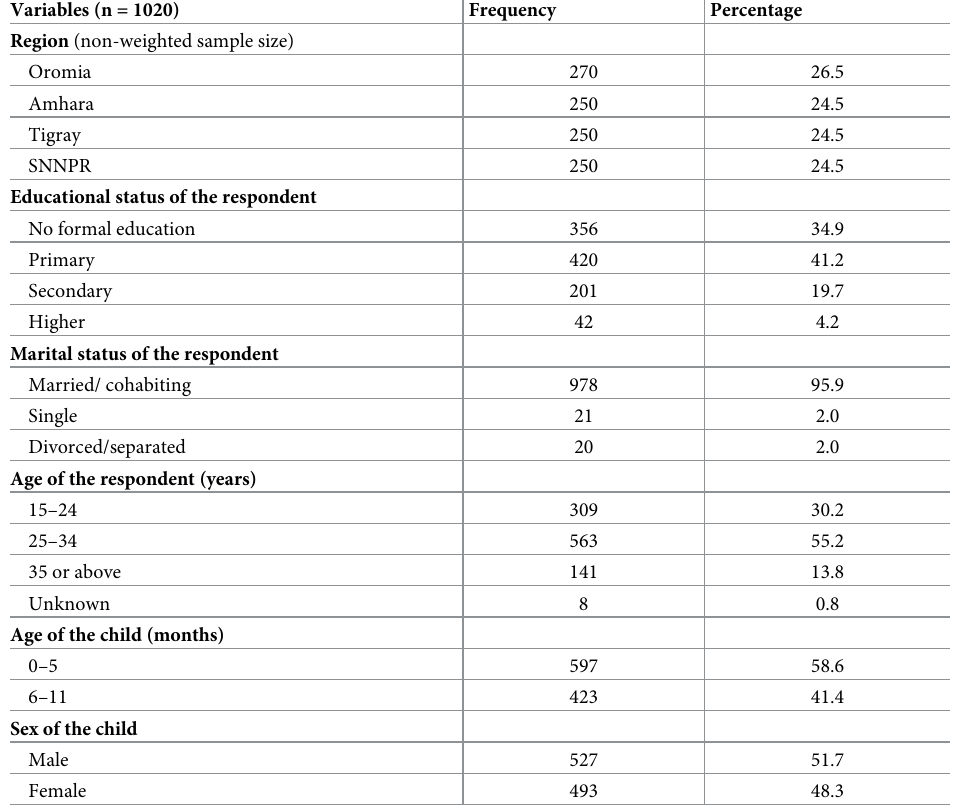
Table 1. Basic characteristic of the study participants and index infants, four regions of Ethiopia, Feb